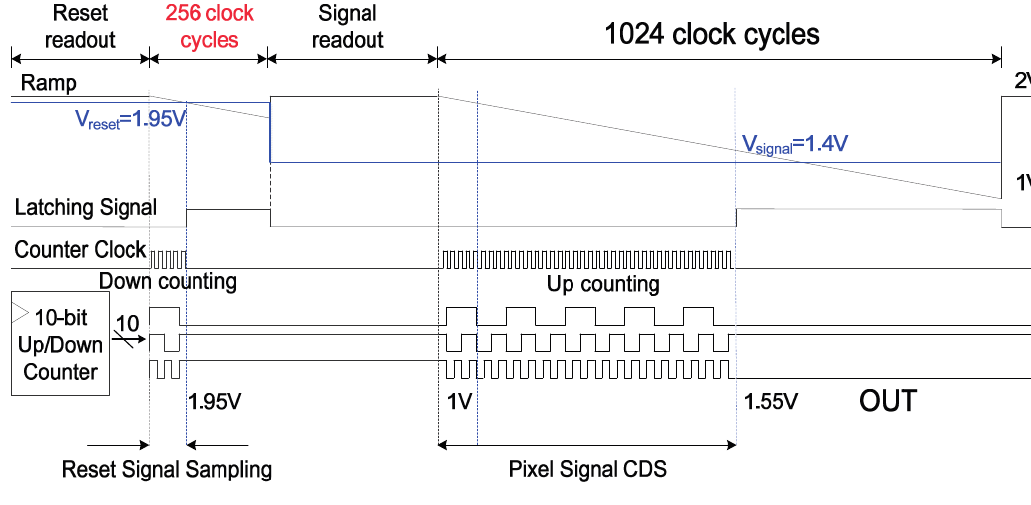
Figure 2. Timing diagram of a SS-ADC with a conventional digital